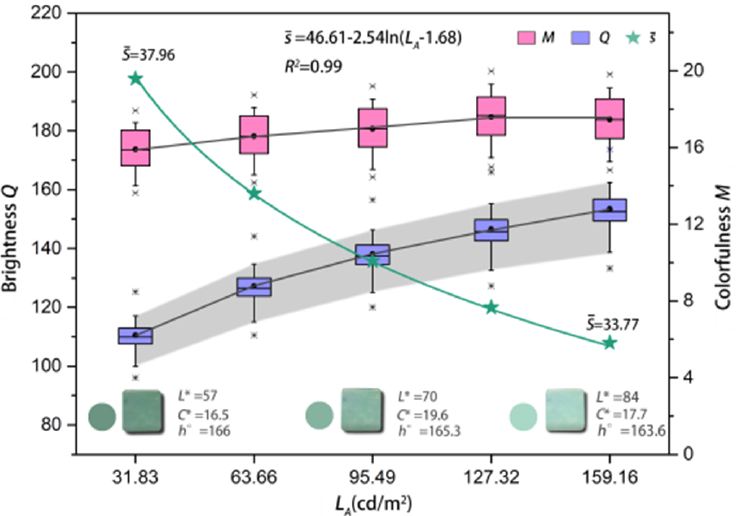
Figure 10. Influence of illuminance change on colour appearance attributes M , Q , and s. Both colourfulness and brightness rise with the increase of illuminance, but the growth rate of Q is much greater than that of M , causing a significant decrease in average saturation.